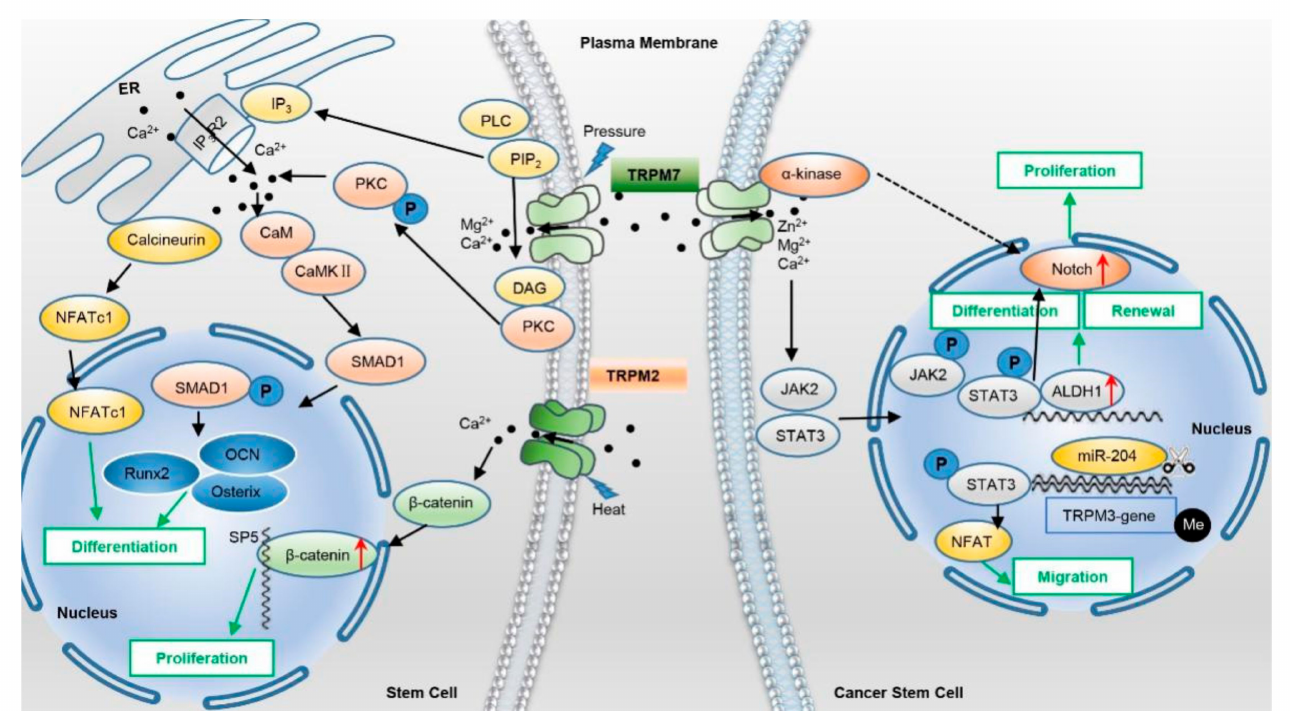
Figure 2. TRPMs function in stem cells and cancer stem cells via different signaling pathways. In MSCs, the Ca 2+ influx via TRPM7 triggers the activation of the PLC signaling pathway, subsequently releases Ca 2+ from ER, and induces nuclear translocation of NFATc1, promoting differentiation in human bone marrow MSCs. Moreover, activation of PLC leads to phosphorylation of PKC and its intracellular translocation, recruitment of CaM, and stimulation of CaMKII, which then phosphorylates SMAD1 and induces its translocation to the nucleus, thereby activating osteogenic genes Runx2, Osterix, and OCN to promote MSC differentiation and osteogenesis. Activation of TRPM2 by heat stress elevates intracellular calcium influx, which inhibits the phosphorylation of β - catenin and results in the augment of β -catenin on the SP5 promoter, promoting NPC proliferation. In GSCs, activation of TRPM7 activates the JAK2-STAT3 signaling pathway, which phosphorylates JAK2 and STAT3 and induces the translocation of JAK2 and STAT3 to the nucleus; STAT3 then activates ALDH1 via binding to its promoter and/or activates Notch signaling, enhancing GSC differentiation, host gene TRPM3 could activate the STAT3-NFAT pathway, promoting GSC invasion and